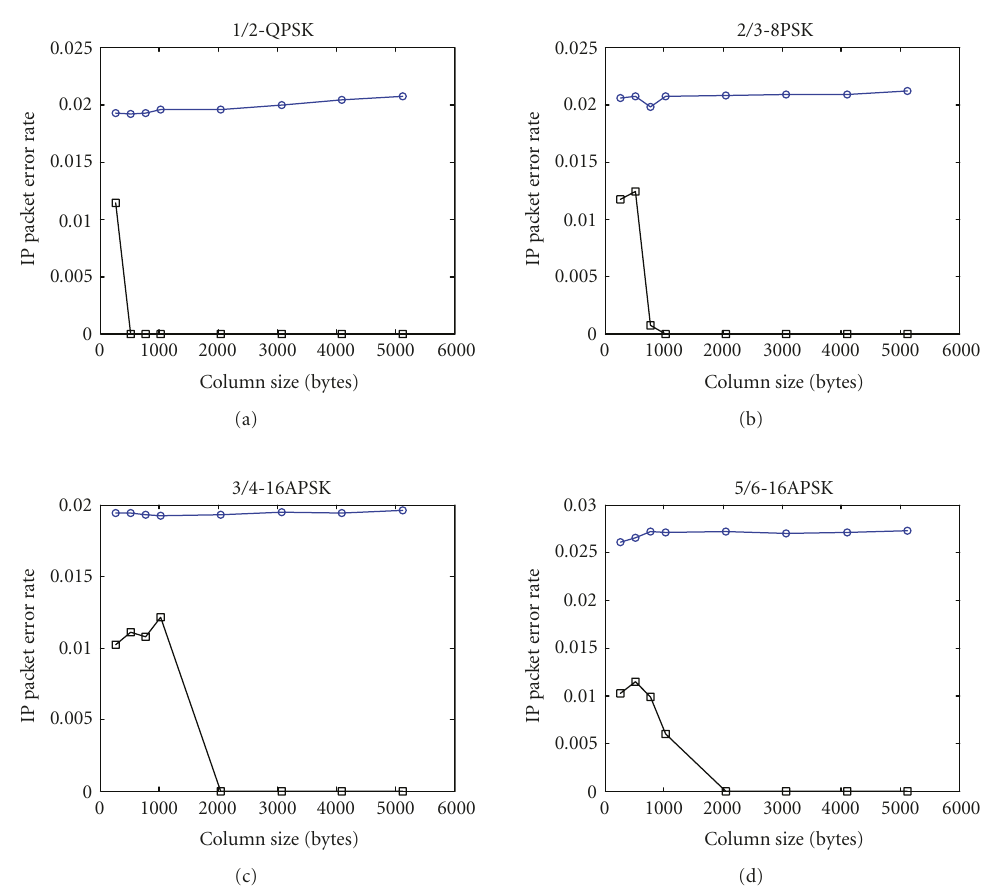
Figure 13: Comparison of the IP packet error rate for di ff erent ACM modes in a channel with BBFRAME error rate equal to 2% (circles → results without any kind of PL-FEC, squares → results with